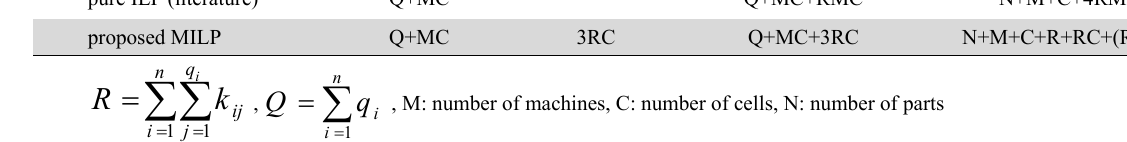
Number of variables 0-1